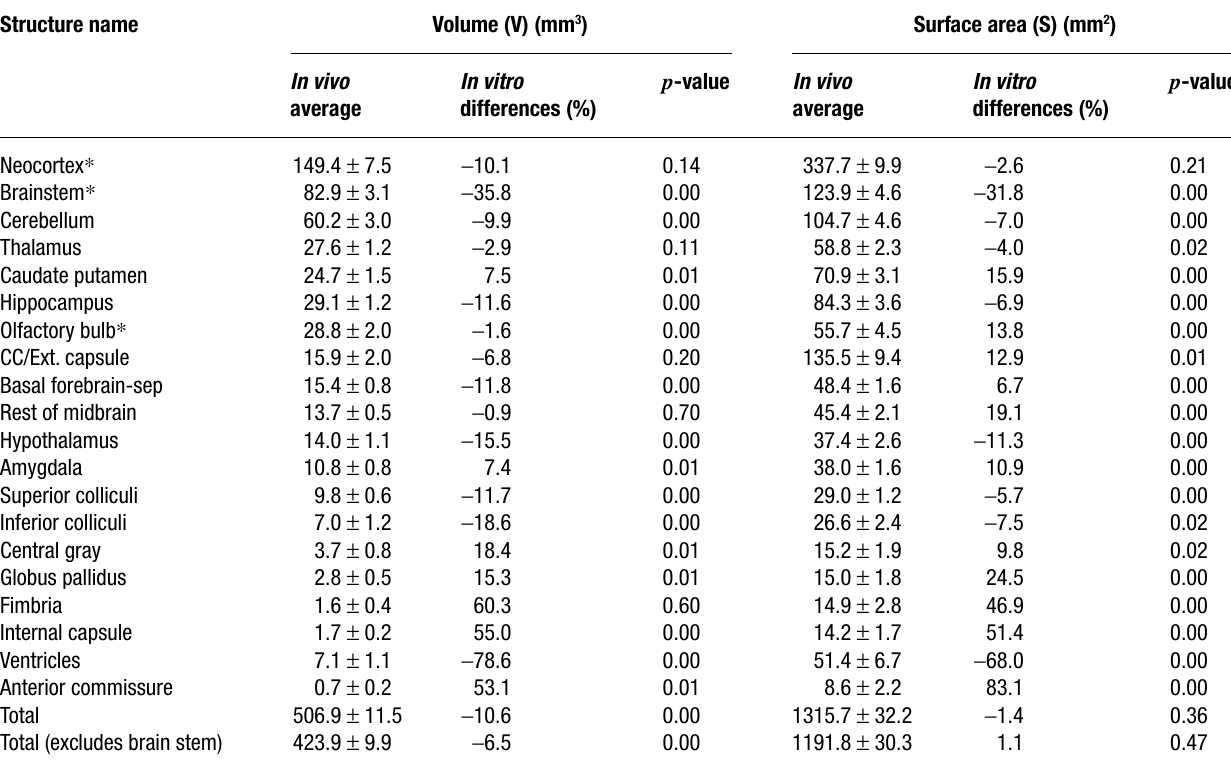
Table 1. The average volume and surface area of the segmented in vivo structures ( n = 12) and the percentage changes compared with the in vitro group ( n = 10) in Ma et al. (2005) (listed in the columns named as ‘ in vitro difference %’).